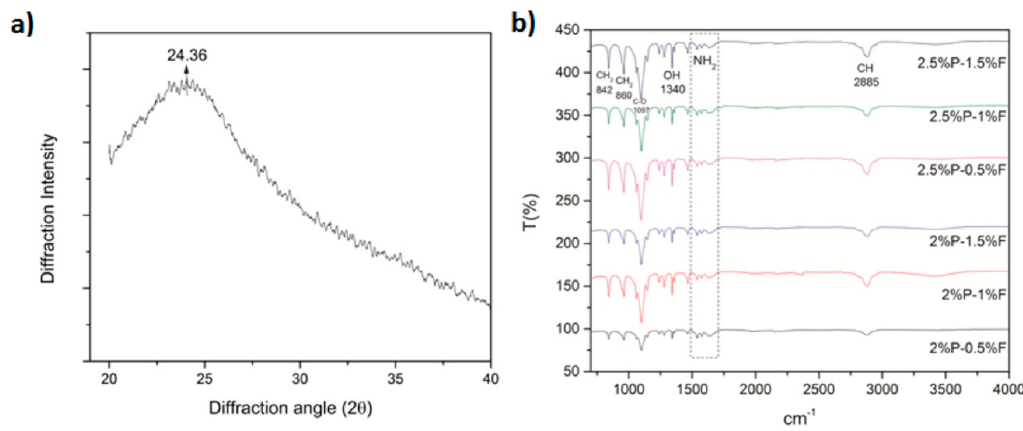
Figure 3. ( a ) Diffraction pattern of silk fibroin; ( b ) FTIR Spectra of PEO–fibroin electrospun scaffolds.